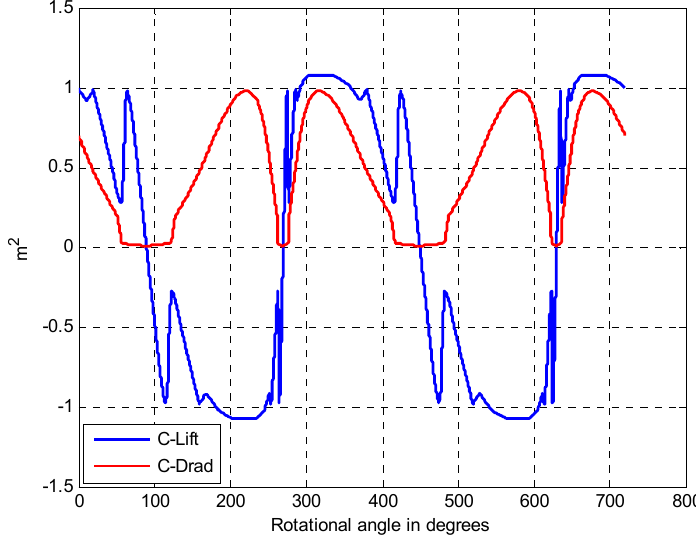
Figure 18. Lift and drag coefficient variations as functions of rotational